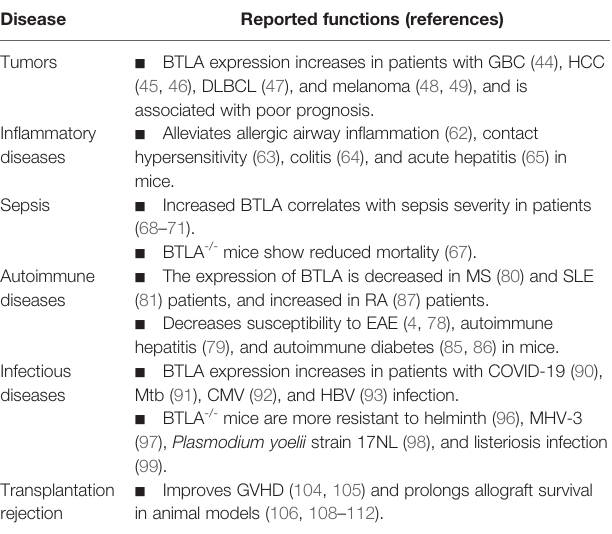
TABLE 1 | Reported functions of BTLA in immune-related diseases.